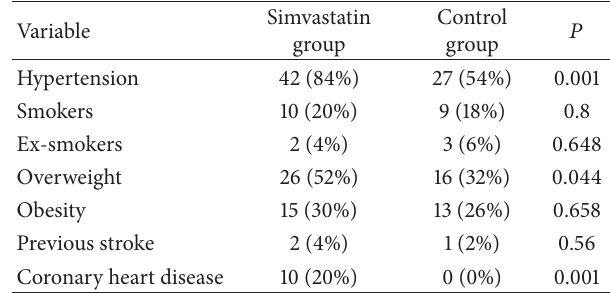
Table 1: Baseline